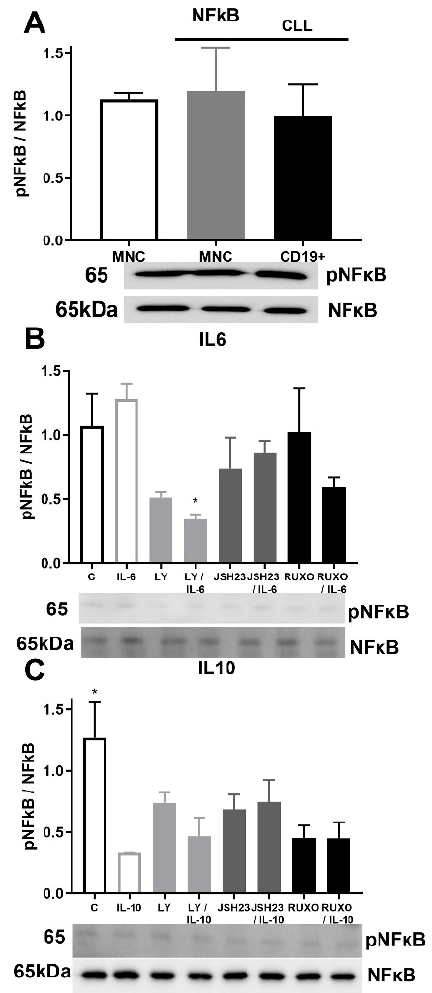
Figure 6. Activation of inflammatory NF- κ B signaling pathway in mononuclear cells (MNCs) of peripheral blood of chronic lymphocytic leukemia (CLL). Activation of NF- κ B signaling in ( A ) MNCs and CD19 + cells of CLL ( n = 3); ( B ) MNCs treated 1 h by 20 µ g/mL IL-6 with and without 0.6 nM Ruxolitinib, 5 nM LY294002, and 0.75 nM JSH23; ( C ) MNCs treated 1 h by 30 µ g/mL IL-10 with and without 1.2 nM Ruxolitinib, 10 nM PI3K inhibitor, and 1.5 nM NF- κ B inhibitor JSH23. Data are presented as mean ± SD ( n = 5). * p < 0.05, versus IL-6 or IL-10 treated MNCs.